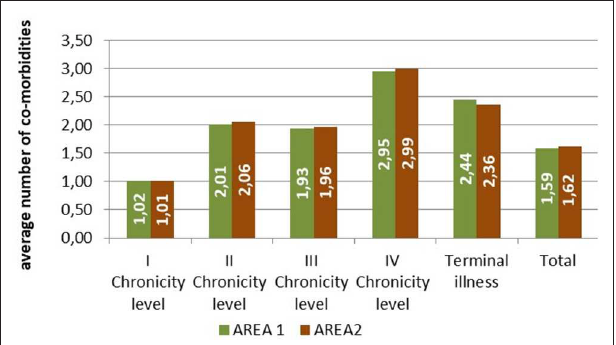
FIGURE 3 | Average number of comorbidities belonging to different diagnostic categories by level of